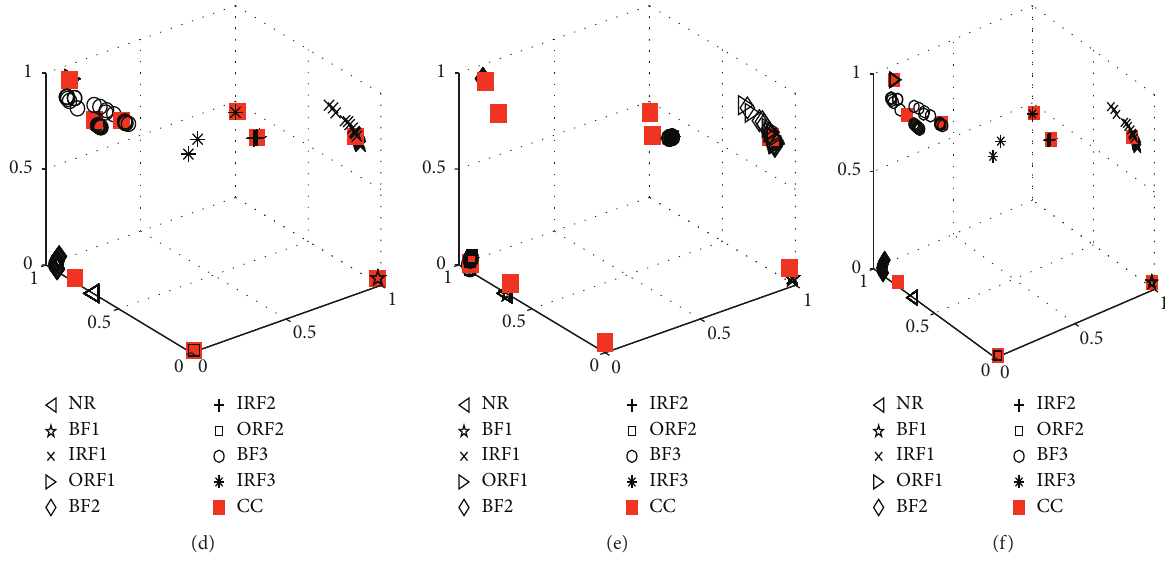
Figure 12: The 3-dimensional clustering results for training dataset B by using an SAE/SDAE with FCM/GK/GG. (a) SAE-FCM-B. (b) SAE-